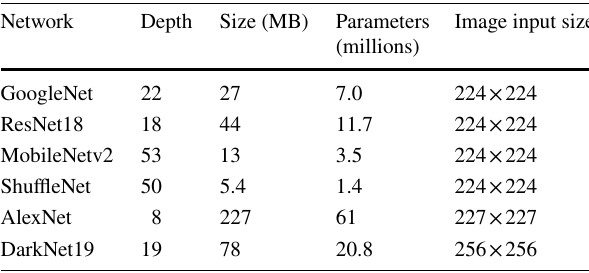
Table 1 Comparison of the characteristics of pre-trained networks Network Depth Size